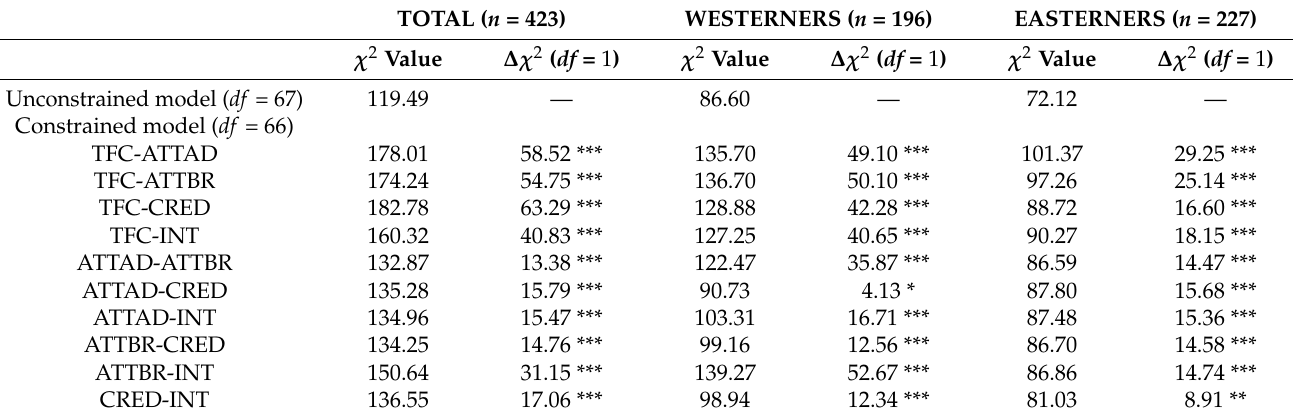
Table 5. Chi-squared difference tests for assessing discriminant